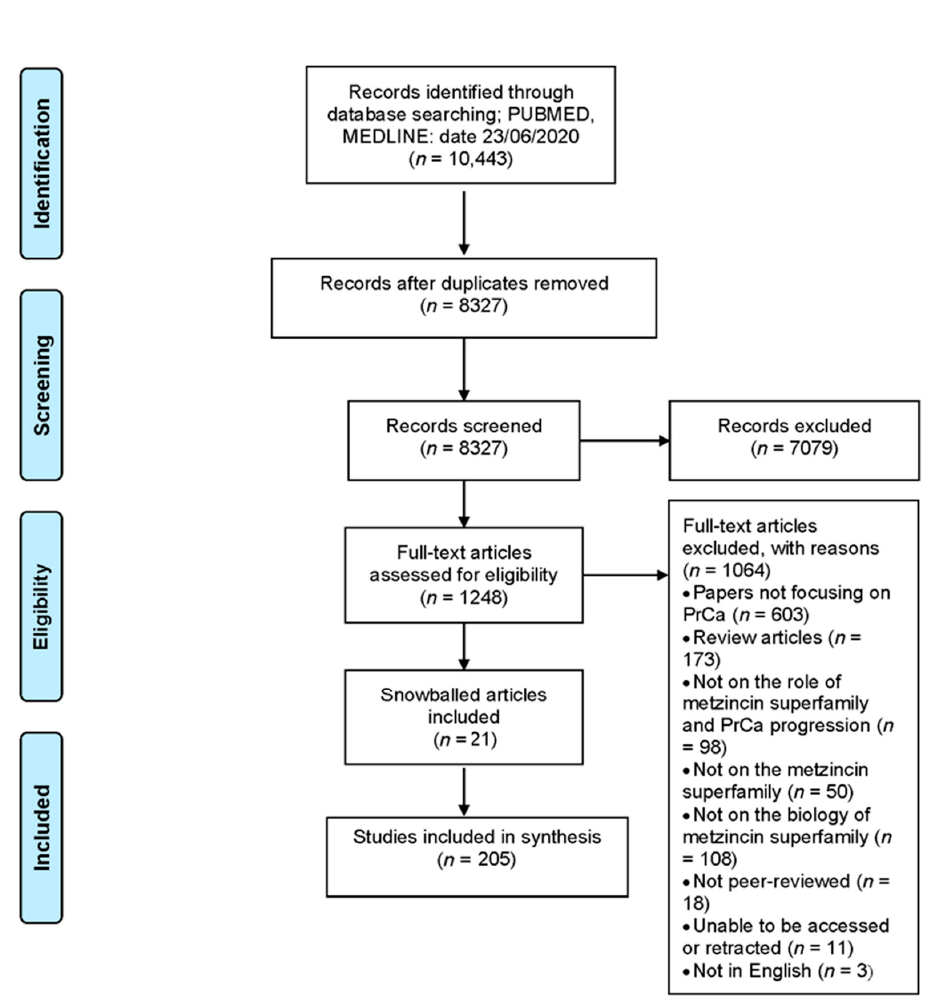
Figure 3. Preferred Reporting Items for Systematic Reviews and Meta-analysis (PRISMA) overview of the systematic-like review. Flow chart of the systematic-like review process undertaken, including the details of identification, screening and assessment for